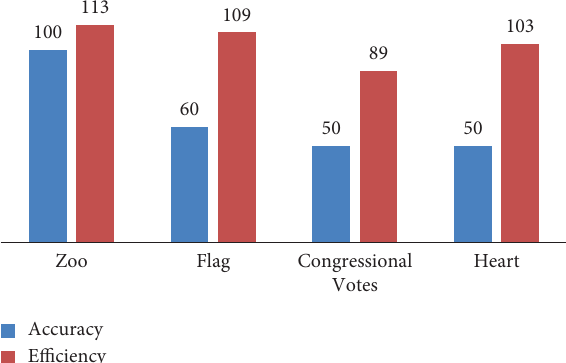
Figure 8: Percent accuracy and efciency for UCI benchmark